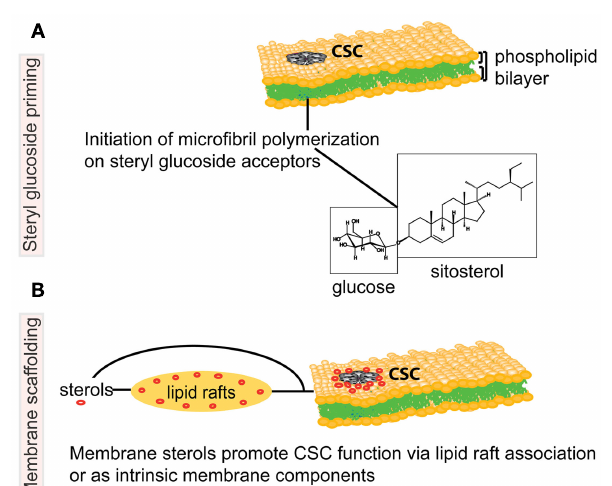
FIGURE 1 | Schematic representation of potential associations between sterols and the cellulose biosynthetic machinery in higher plants. The cellulose synthase complex (CSC) is embedded in the phospholipid bilayer of the plasma membrane (PM), and catalyzes production of a cellulose microfibril, a major constituent of the plant cell wall. In the upper model (A) , steryl glucosides (SGs) comprised of sitosterol (molecule shown in boxes) prime the synthesis of glucan chains as proposed by Peng et al. (2002).The lower model (B) depicts molecular interactions whereby sterols (in red) are necessary for the correct targeting, structural integrity and/or catalytic activity of the CSC.The proposed molecular interactions between sterols and the CSC may occur in PM microdomains, also known as lipid rafts, or via another form of molecular scaffolding. Note that the proposed models are not mutually exclusive. Figure is not drawn to